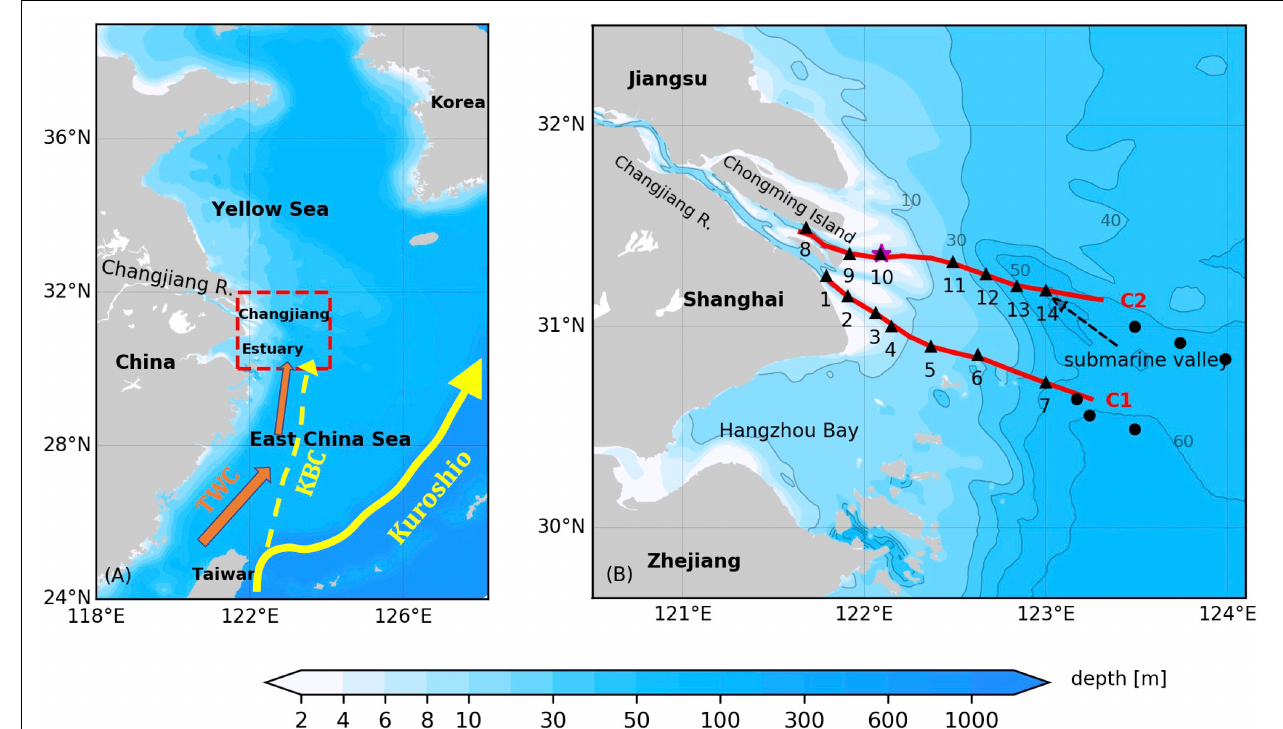
FIGURE 1 | (A) Bathymetry of the East China and Yellow Seas. The Changjiang Estuary and adjacent shelf area that the study is focused on is marked by the red dashed box. The Kuroshio Current, the Kuroshio Branch Current (KBC) and the Taiwan Warm Current (TWC) are indicated in the map. (B) Bathymetry of the study area. The red lines denote the AESS transects surveyed, the black triangles denote CTD stations following the AESS surveys, the black dots denote the CTD stations from the open research cruise, and the purple star denotes the release location of surface drifters. The gray lines are the bathymetry contours of 10 m, 30 m, 40 m, 50 m and 60